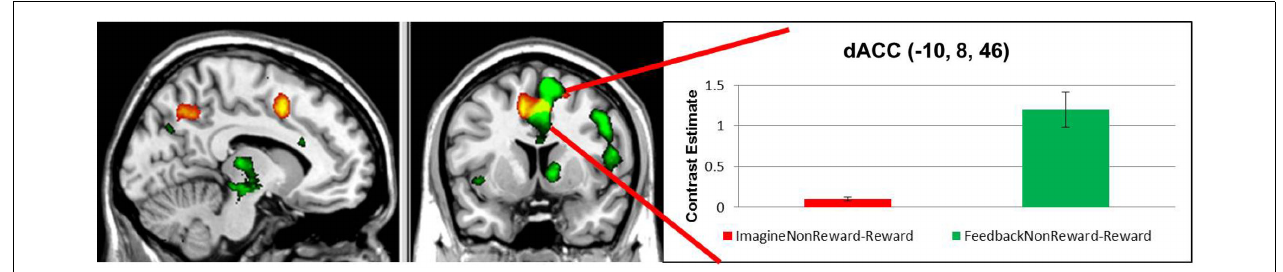
greater activation for non-rewarding feedback contrasted with rewarding feedback, depicted at p < 0.001, uncorrected.Yellow: regions common to both